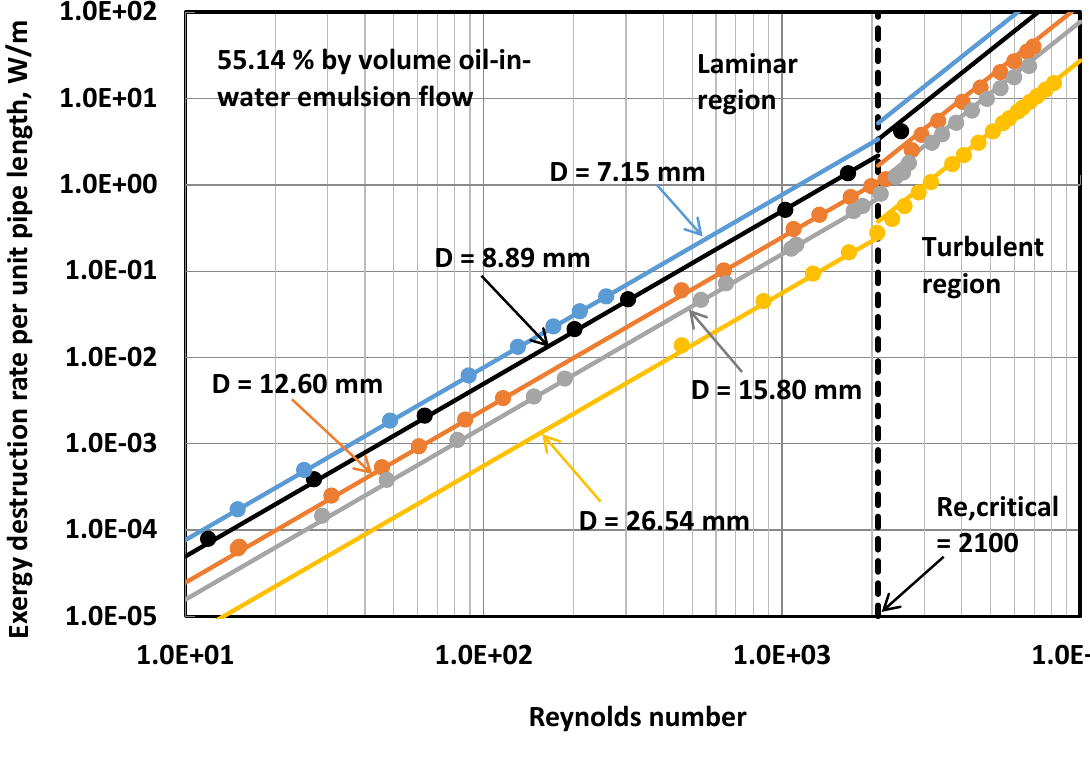
  versus Re plots for 55.14% by vol. O/W emulsion flow in different diameter Figure 12. D